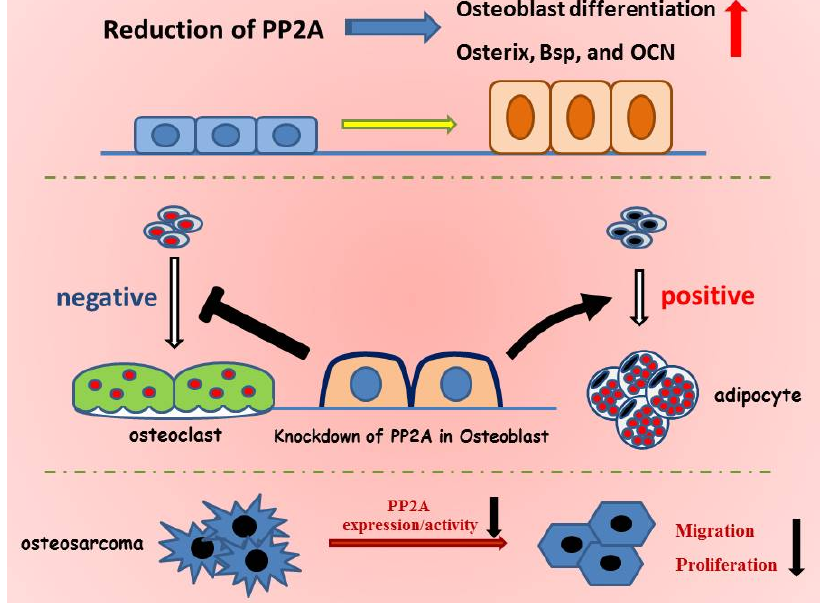
Figure 1. PP2A regulates osteoblast differentiation and function. PP2A is thought to have critical roles in not only osteoblast differentiation but also in the regulation of the differentiation of the surrounding cells such as adipocytes and osteoclasts. A reduction in PP2A accelerates osteoblast differentiation and bone formation through upregulation of the expression of bone-related genes including ALK phosphatase, Osterix, Bsp, and OCN. Downregulation of PP2A in osteoblasts negatively controls osteoclast differentiation by reducing the ratio of sRankL/OPG; in contrast, it positively regulates adipocyte differentiation by increasing the expression of adipocyte-related genes such as PPAR γ and C/EBP α . Furthermore, greater expression of PP2A is observed in osteosarcoma cells and a reduction in PP2A suppresses the proliferation, migration, and metastasis of osteosarcoma cells.